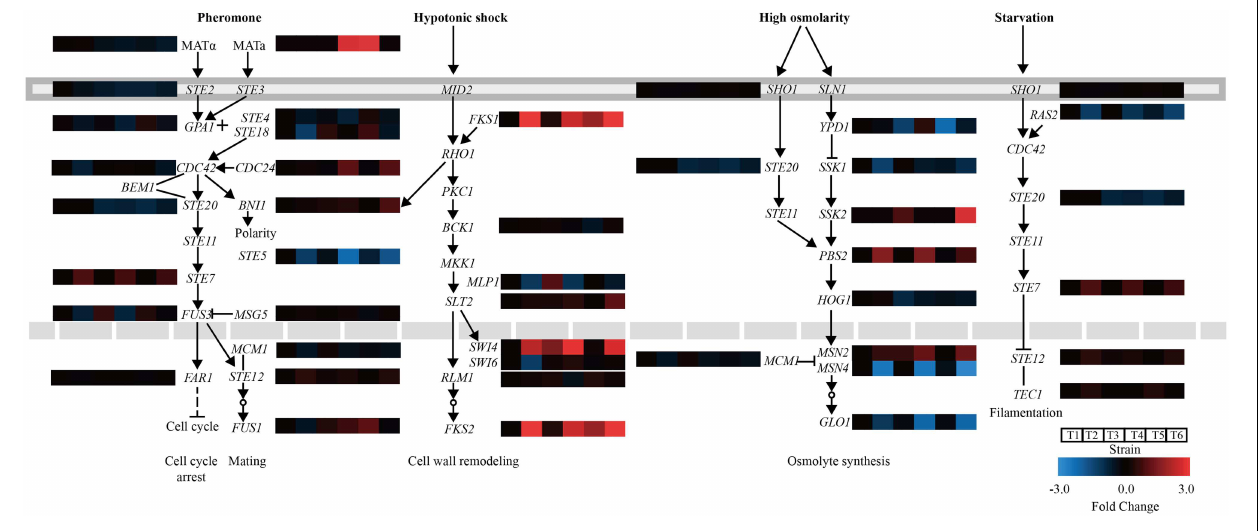
FIGURE 6 | Changes in gene expression and MAPK signaling pathways in Cgasg1 1 and Cghal9 1 strains. Transcriptional profiling of genes involved in MAPK signaling pathways were compared, including the mating pheromone response, the cell wall integrity